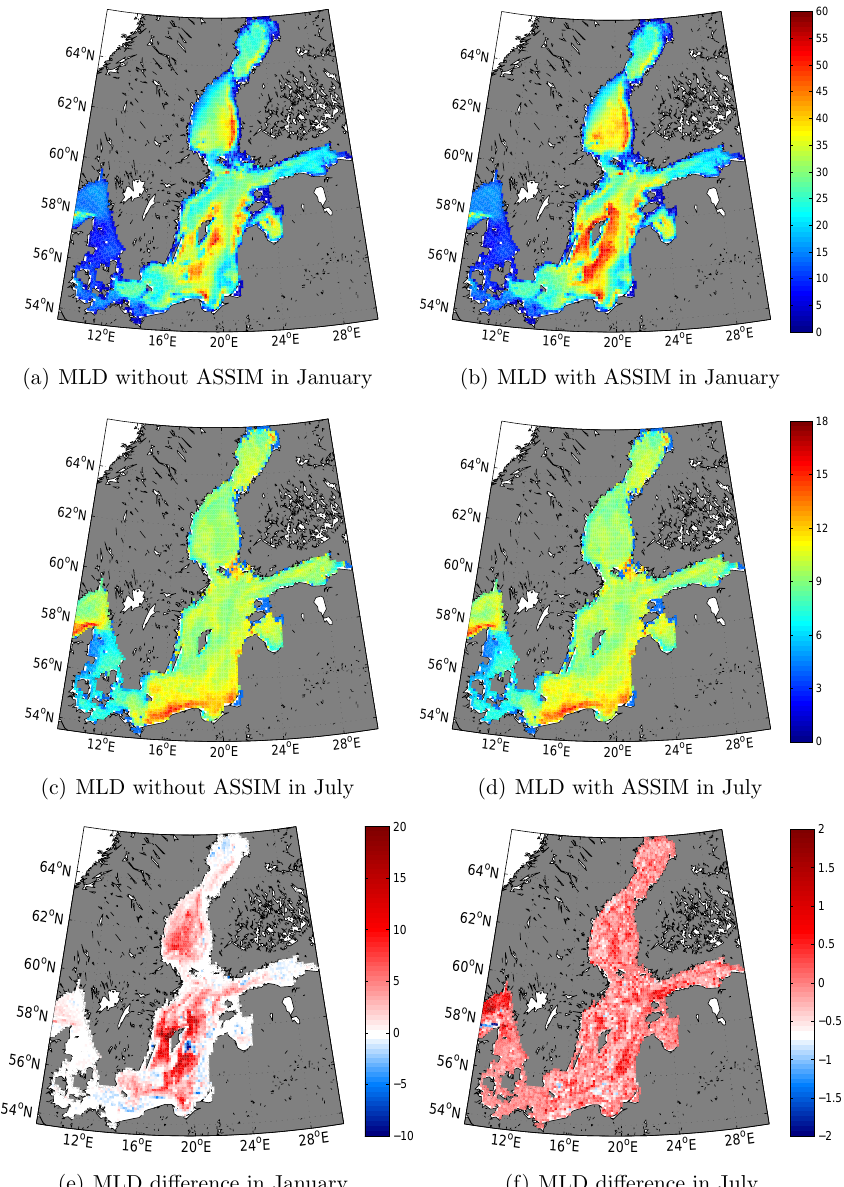
Fig. 11. The climatological mean mixed layer depth (MLD) (unit: m) calculated from the free run and reanalysis for 20-year period. Figure 11: The climatological mean mixing layer depth (MLD) calculated from the free run and reanalysis for 20-year period. temperature and salinity throughout the layer. The depth